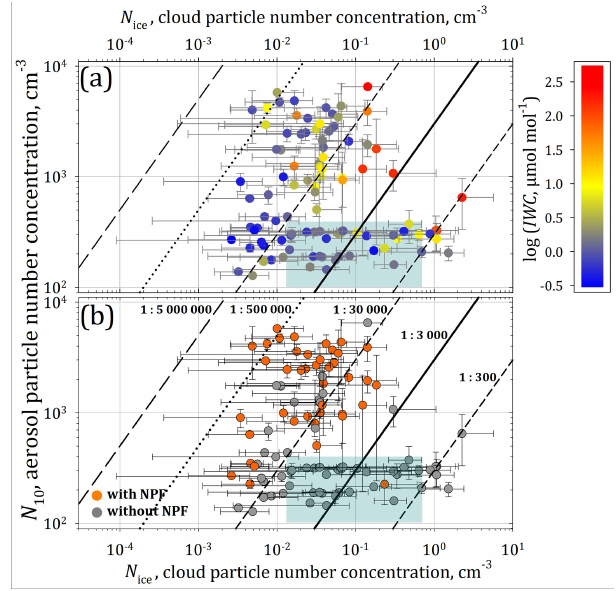
Figure 5. StratoClim 2017 data of the total number concentration N 10 together with coincident detections of N ice (i.e. N 3–937µm ) by the NIXE-CAPS. The vertical bars represent the standard de- viation over the averaging periods. Data points are colour-coded in panel (a) with reference to IWC. (b) NPF encounters (orange) throughout the averaging period (otherwise grey). Shaded blue ar- eas in both panels indicate the range of most of the data points pro- vided by de Reus et al. (2009). Reference lines for concentration ratios of 1:300 and 1:30000 (as in de Reus et al., 2009) and here additionally for 1:500000 and 1:5000000 are